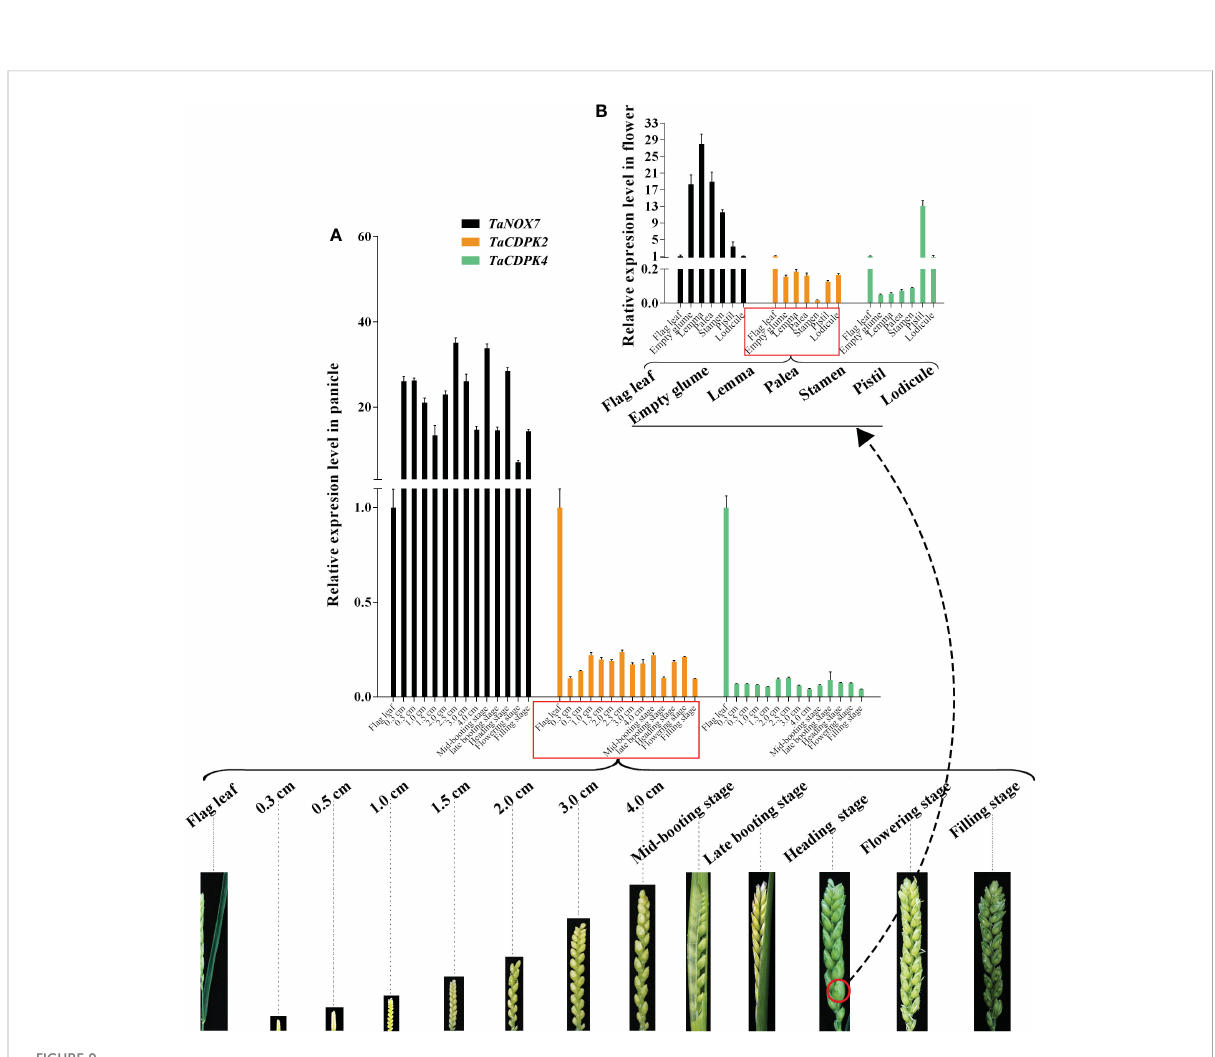
FIGURE 9 Co-expression interactions between TaNOX7 and TaCDPK2/4 in wheat. (A) Co-expression of TaCDPK2 / 4 and TaNOX7 in panicles from 12 different developmental stages; (B) Co-expression of TaCDPK2 / 4 and TaNOX7 in six fl ower organs at heading